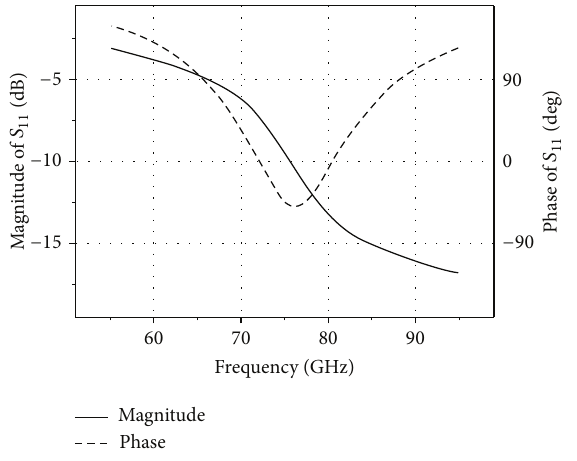
Figure 4: Magnitude and phase of reflection coefficient versus geometrical parameter B.